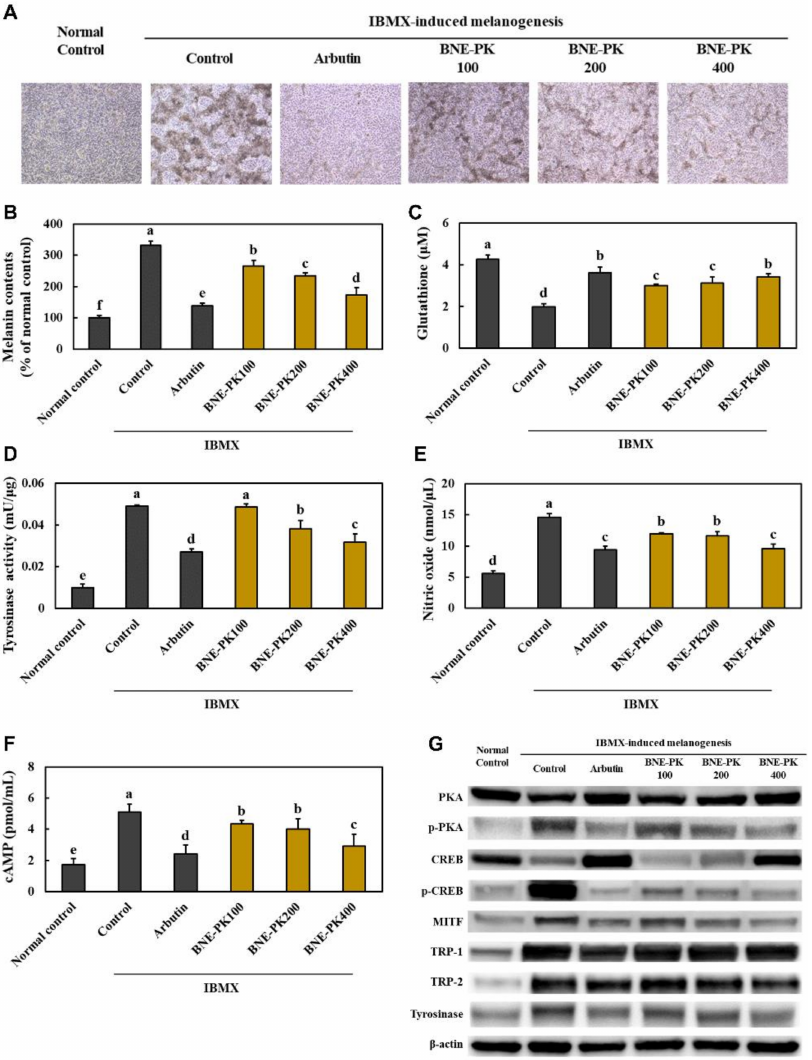
Figure 5. Effects of BNE-PK on the melanin contents ( A , B ), glutathione ( C ), tyrosinase activity ( D ), nitric oxide ( E ), cAMP ( F ), and PKA/CREB/MITF/TRP-1/TRP-2/tyrosinase pathway ( G ) in IBMX- treated B16F10 cells. Normal control (NC; − IBMX), control (C; + IBMX), arbutin (positive control; arbutin treatment at 100 µ g/mL), and BNE-PK treatment at various concentrations (100, 200, and 400 µ g/mL). Values are presented as mean ± SD. Different letters indicate a significant difference, with p < 0.05, as determined with Duncan’s multiple range